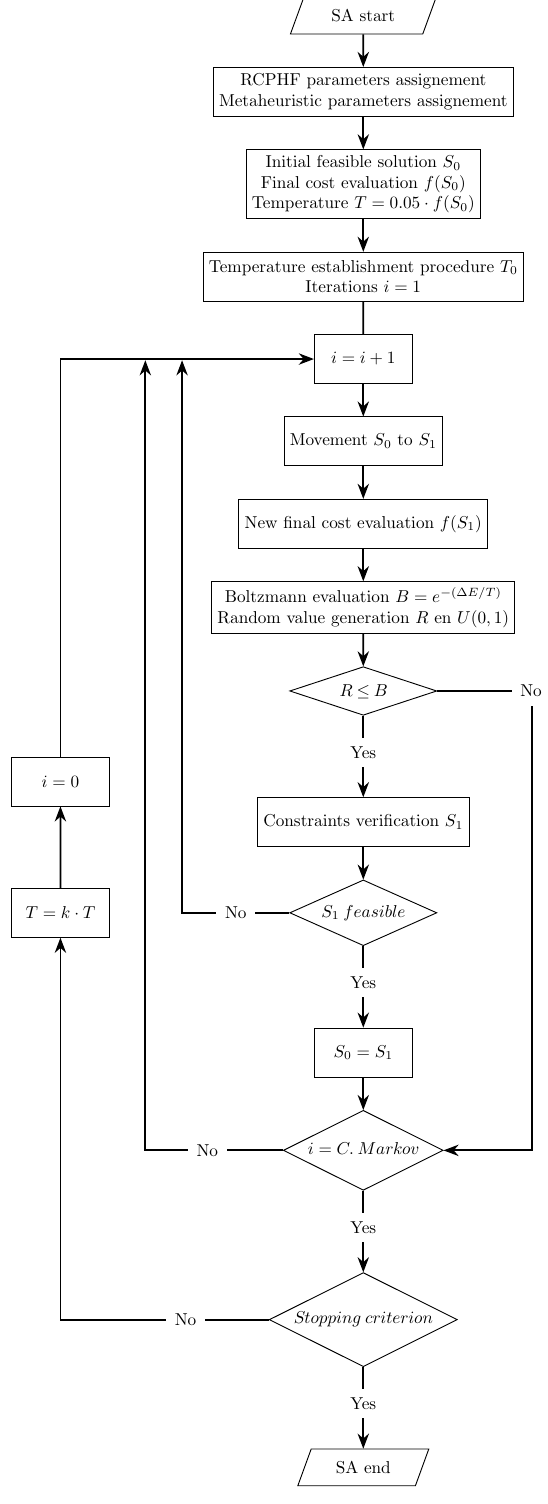
Figure 3. Flowchart of the simulated annealing (SA)